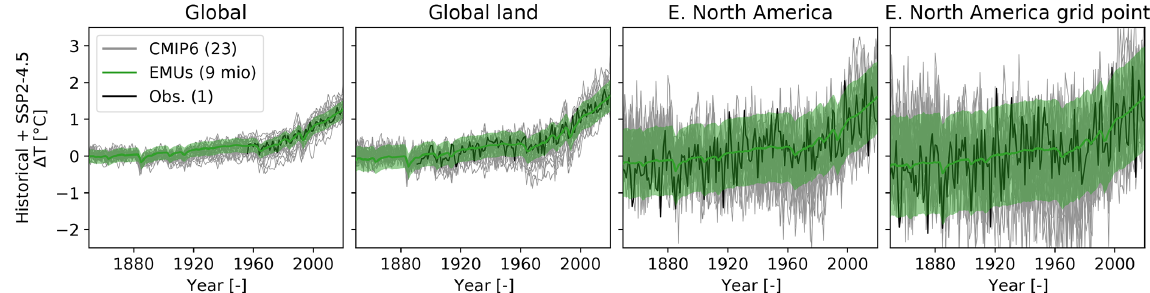
Figure 7. Temperature anomaly distribution for the emulated globally constrained probabilistic MAGICC–MESMER ensemble, actual CMIP6 simulations, and observations averaged across different spatial scales: global, global land, eastern North America, and a single grid point within eastern North America for the period covered by observations, i.e., the historical time period extended with the middle of the road future scenario (SSP2-4.5). For the MAGICC–MESMER ensemble, the median and the 90% range (5th–95th percentile) of the temperature anomaly distribution is shown in color. For the ESMs, a single simulation per available ESM for that scenario is depicted in gray. The observations are shown in